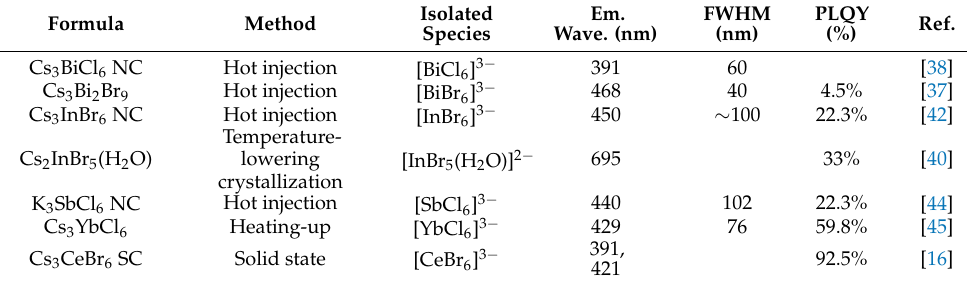
Table 3. Properties of 0D metal halide with trivalent